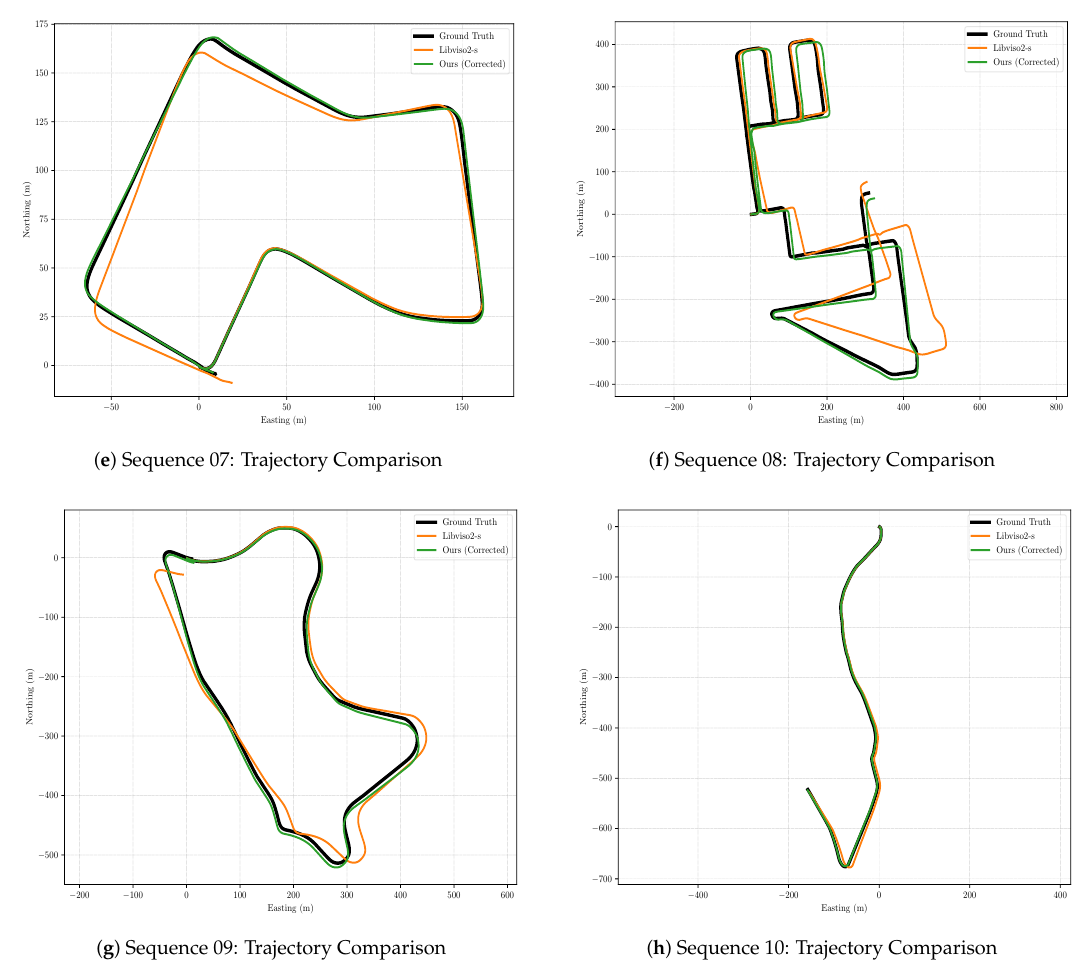
Figure 5. Corrected libviso 2- s trajectories on KITTI sequences 00, 02, 05-10. We show the original libviso 2- s estimate for comparison.